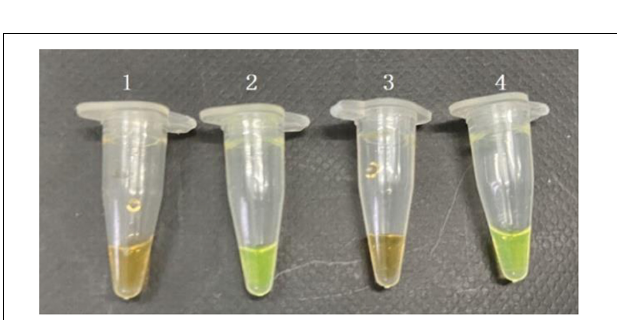
FIGURE 4 | Detection of the viable but non-culturable (VBNC) state of S. aureus in pure cultures and food samples by PMA-CPA assays. 1, dead cells in pure cultures; 2, VBNC cells in pure cultures; 3, dead cells in food samples; 4, VBNC cells in food